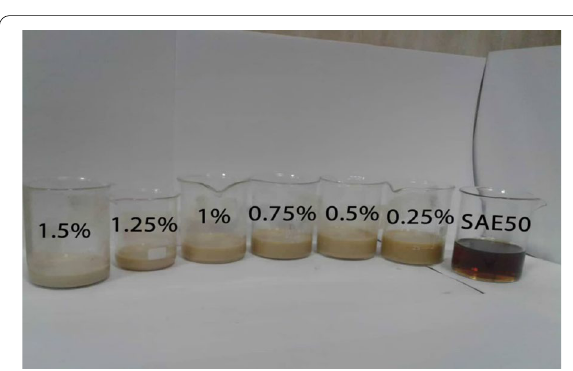
Fig. 3 Hybrid nanofluid samples prepared respectively in various